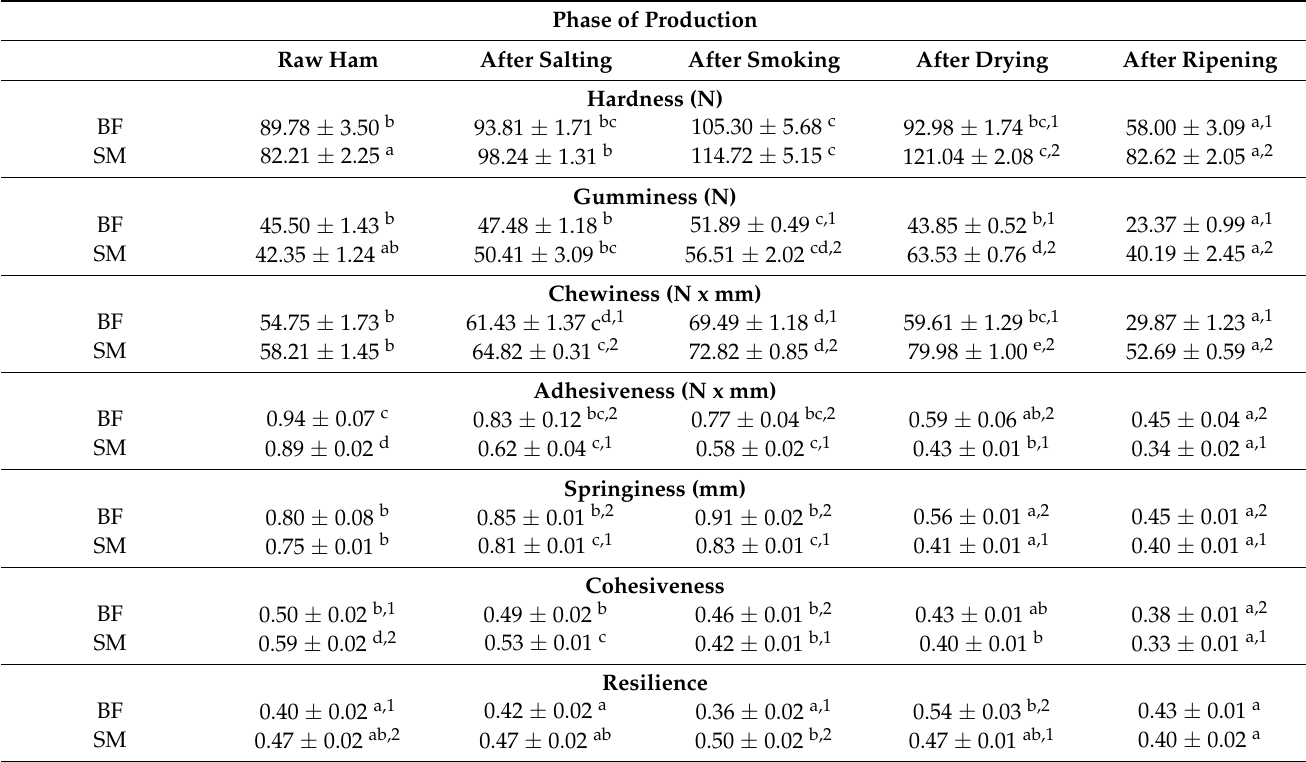
Table 3. Textural parameters investigated on two muscles (biceps femoris (BF) and semimembranosus (SM)) through the manufacturing of smoked dry-cured ham (results expressed as mean ± standard error).